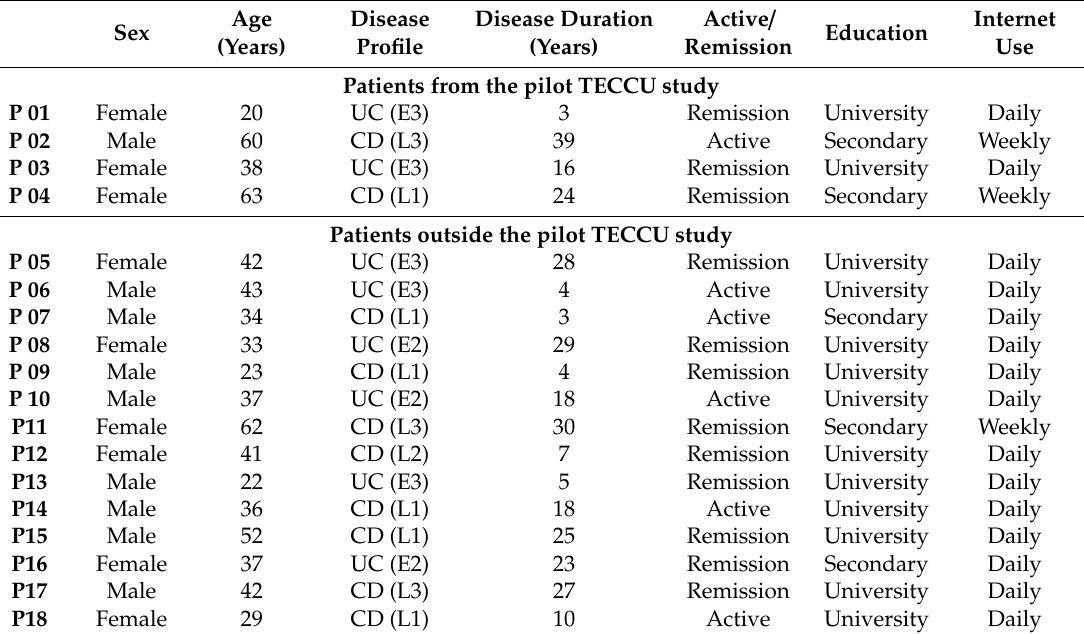
Table 1. Demographics and characteristics of